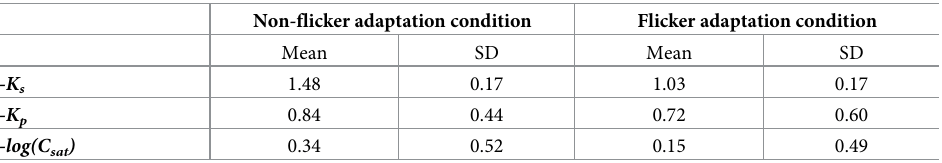
Table 1. Descriptive statistics for the free